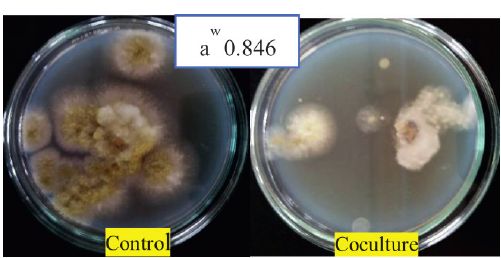
Fig. 13. Maximum antagonism of A. giganteus observed against pathogenic A. flavus at water activity of 0.846 where mycelia formation was